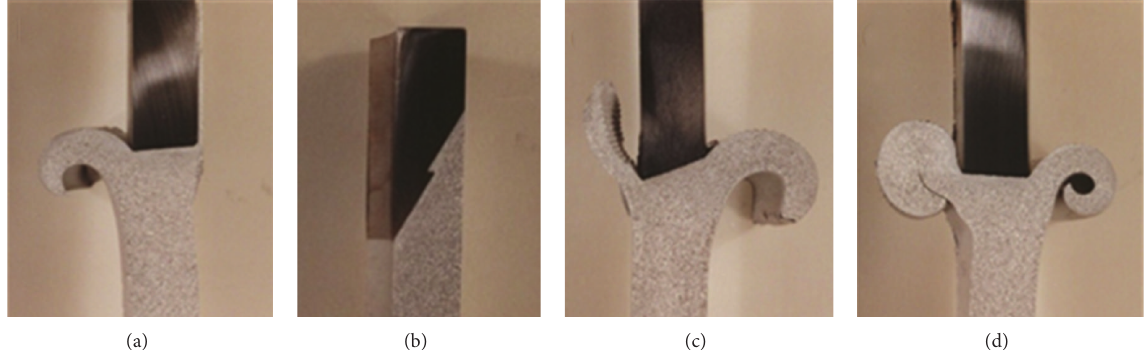
Figure 11: The microstructure of the friction welded AlMg3 aluminium alloy-X10CrNiTi189 austenitic steel joint, with a diameter of 30 mm and substantial roughness of the contact surface (a) and the microstructure of such joint (b).